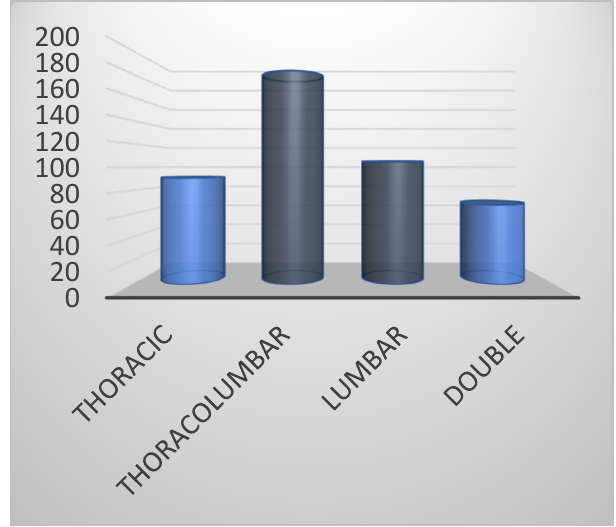
Figure 1. Curve type distribution.